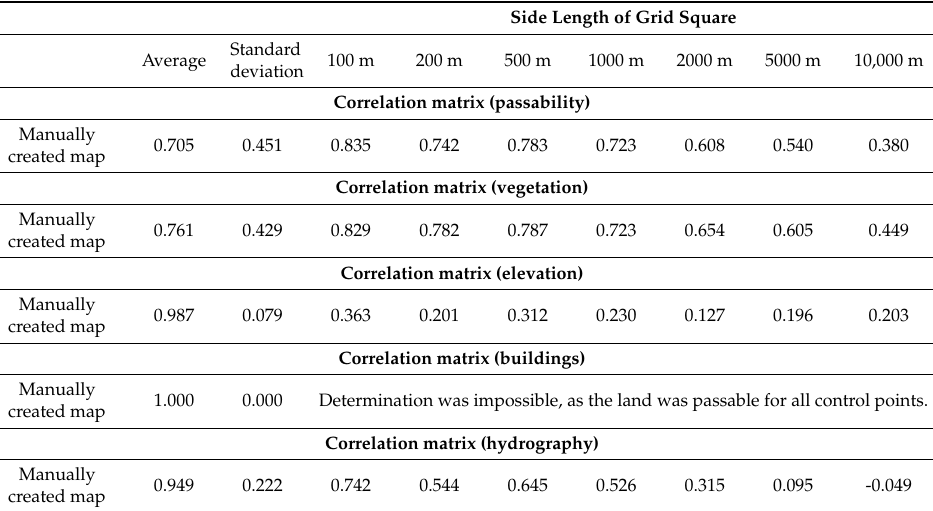
Table 10. Correlation matrices and basic statistic parameters for the 5000 m mesh control points